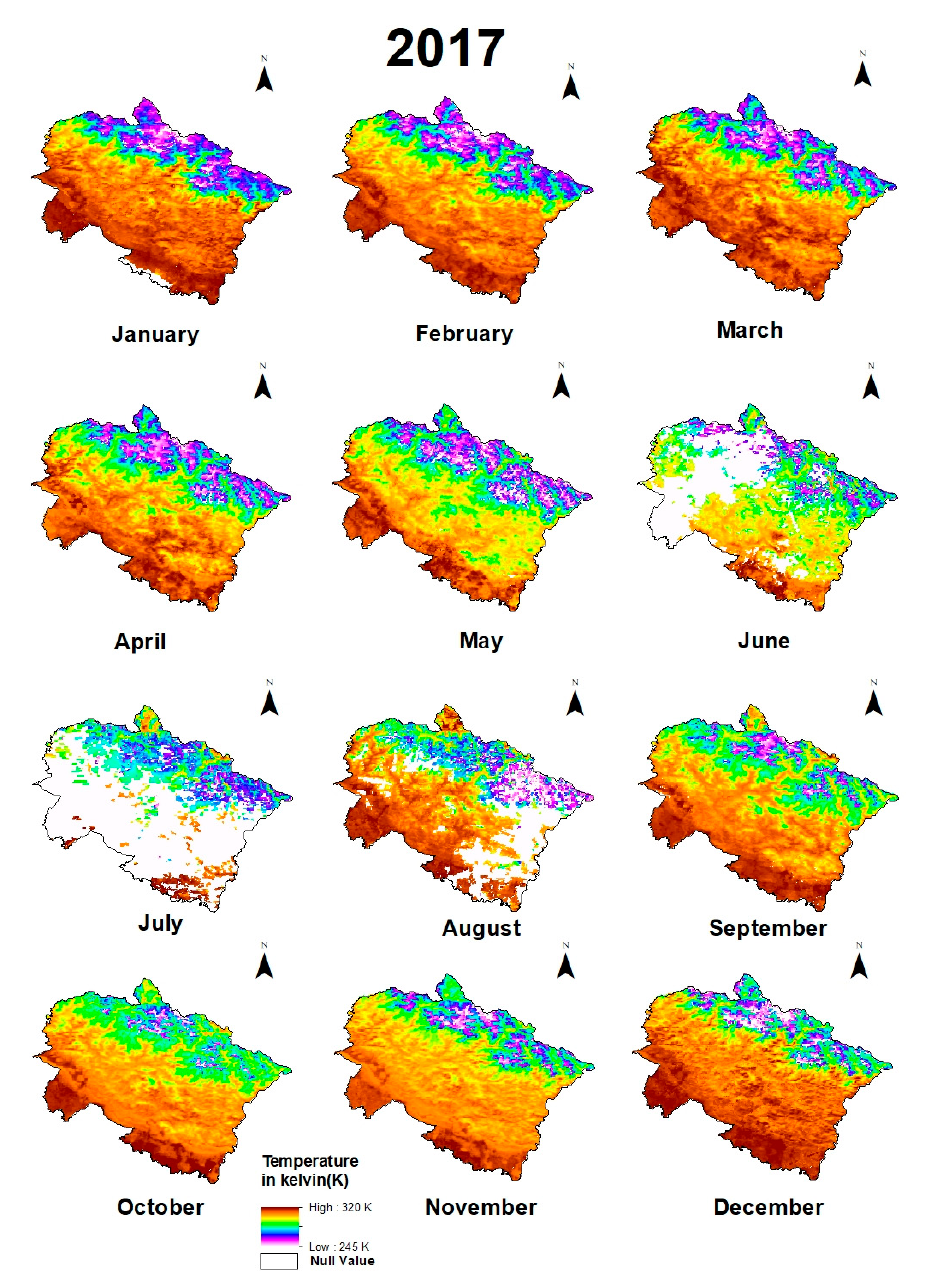
Figure 6. Monthly fluctuations of temperature in Uttarakhand in 2017.